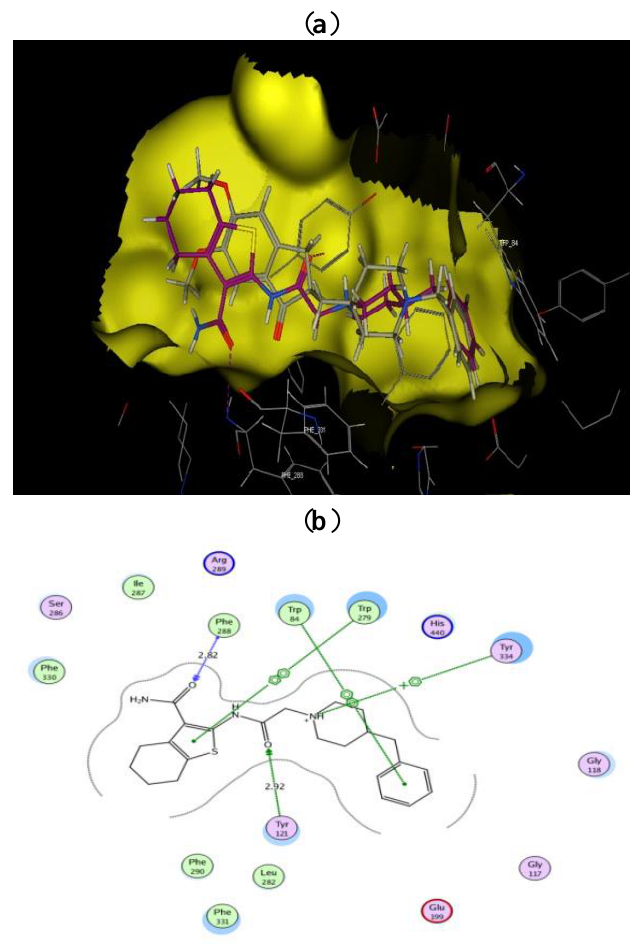
Figure 4. ( a ) Docked conformation alignment of III (red) and its original co-crystallized a ligand (grey) in the AChE binding site generated by MOE docking. ( b ) simplified structure showing interaction between III and the aromatic residues in the AChE active a